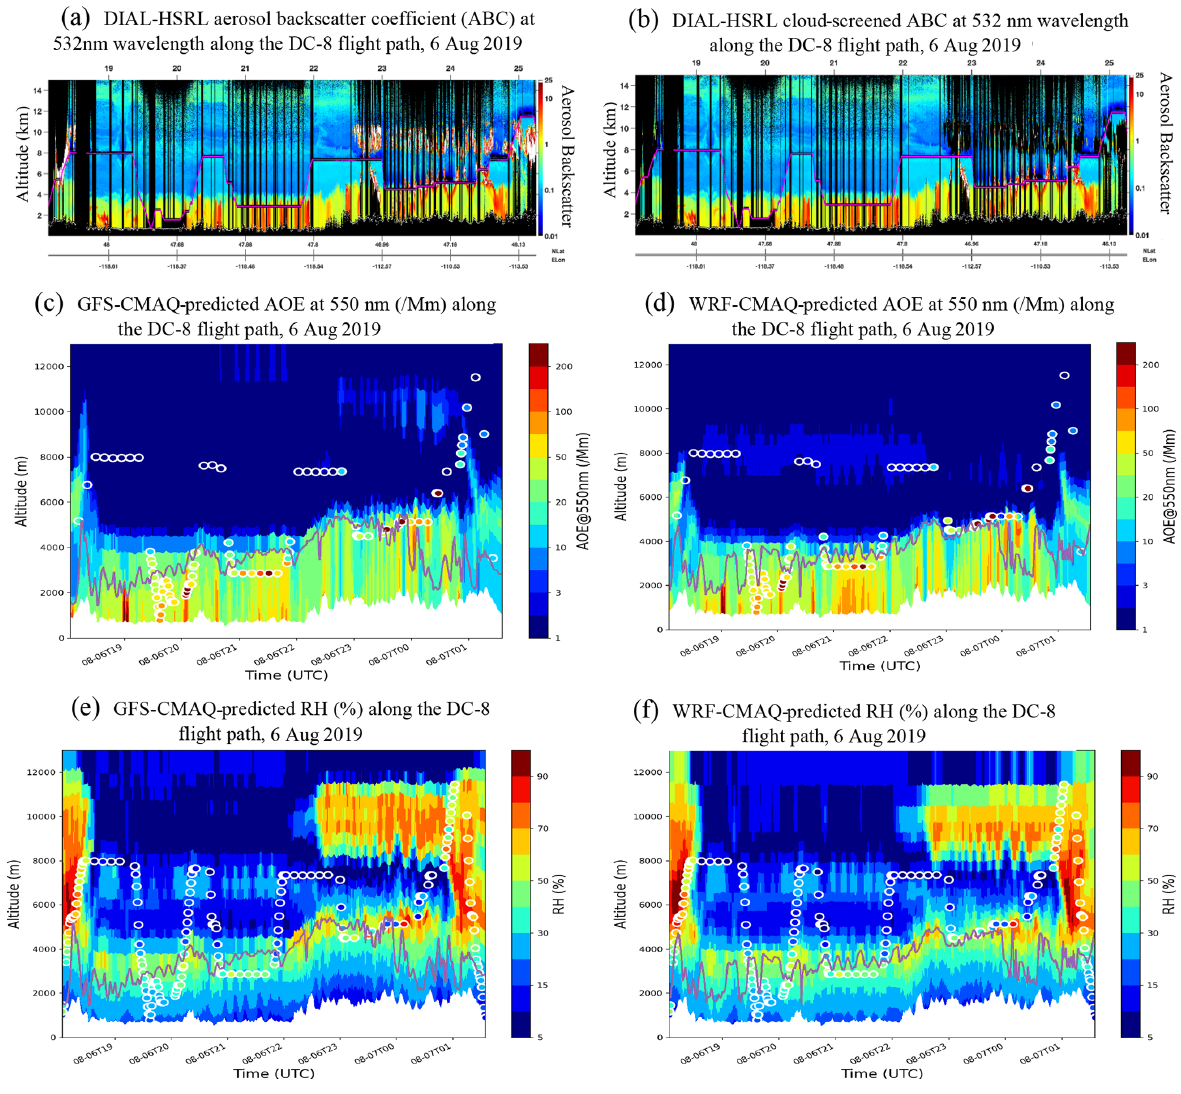
Figure 11. The differential absorption high-spectral-resolution lidar (DIAL-HSRL) retrieved aerosol backscatter coefficients (ABCs) at a 532nm wavelength in steradians per kilometer (a) , the cloud-screened ABCs (b) , curtain plots of the AOEs (b, c) , and relative humidity (RH) predicted by (d) GFS-CMAQ and (e) WRF-CMAQ along the DC-8 flight on 6 August 2019. The colored dots show the corresponding measured values, and the solid lines show the predicted PBL heights of these two